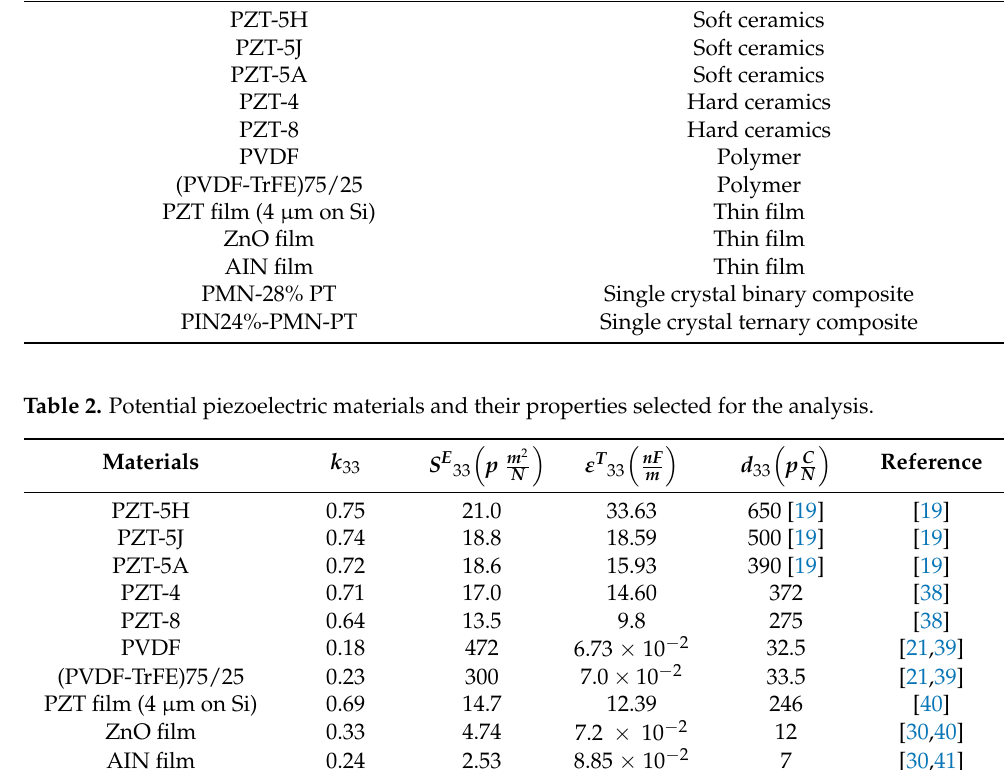
Table 1. Potential piezoelectric materials for the material selection analysis and their material categories. Material